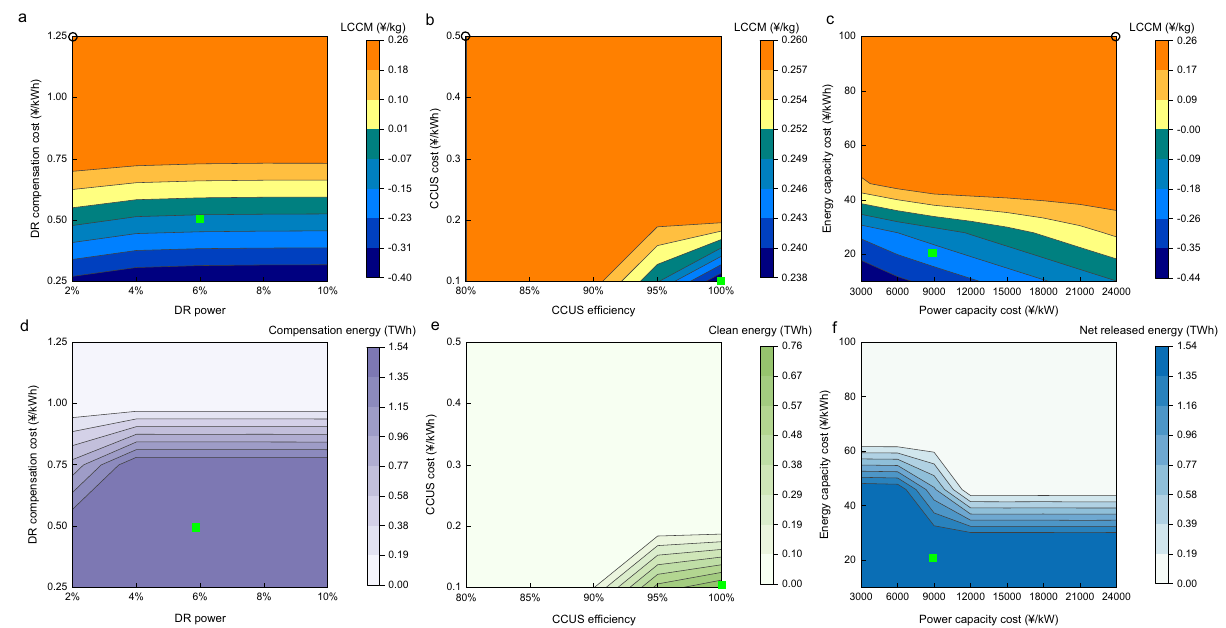
Fig. 5 Levelized cost of CO 2 mitigation (LCCM) and compensation energy under different techno-economic parameters. a LCCM of coal power to natural gas power (C2N) + demand response (DR) under different DR compensation cost and DR power levels. b LCCM of C2N + carbon capture, utilization, and storage (CCUS) under different CCUS costs and ef fi ciencies. c LCCM of C2N + long-duration (LD) under different power and energy capacity cost levels. d Compensation energy for C2N + DR under different DR compensation cost and DR power levels. e Clean energy for C2N + CCUS under different CCUS costs and ef fi ciencies. f Net released energy for C2N + LD under different power and energy capacity cost